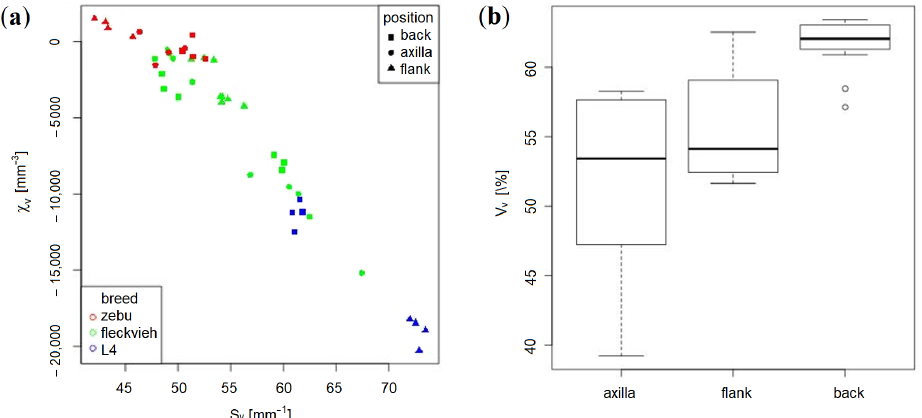
Figure 8. ( a ) Euler number density χ V and specific surface area S V for the 11 × 4 investigated (sub-)samples and ( b ) solid volume fraction for each position within the hide.